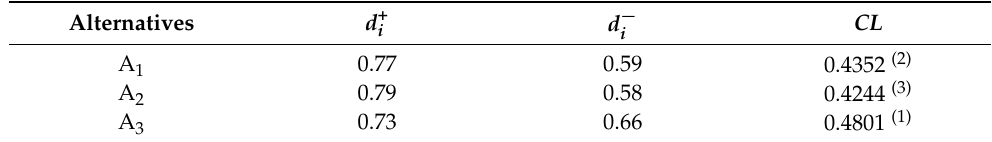
Table 11. The distances and relative closeness of three alternatives with respect to the positive idea solution (Note: superscript numbers represent the rank of the